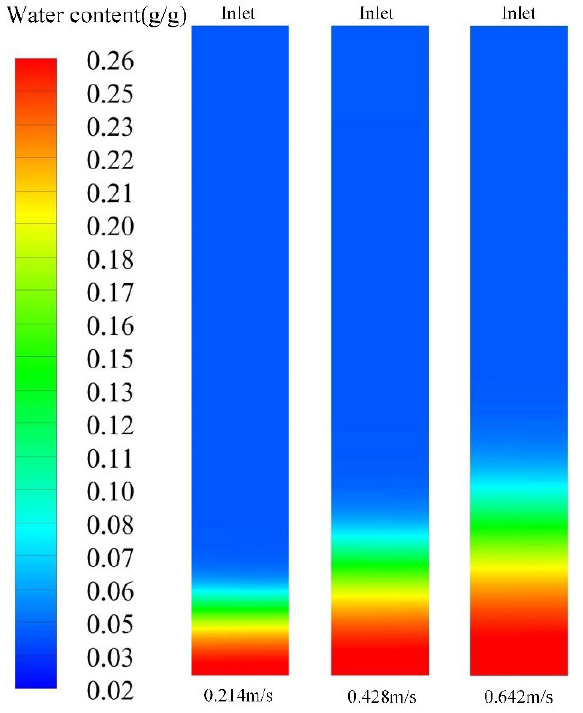
Figure 10. Distribution cloud of the water content of materials in the reactor when the outlet tem- ◦ C at different air inlet velocities of perature of the charging process reached 51.25 °C at different air inlet velocities of charging. temperature of the charging process reached 51.25